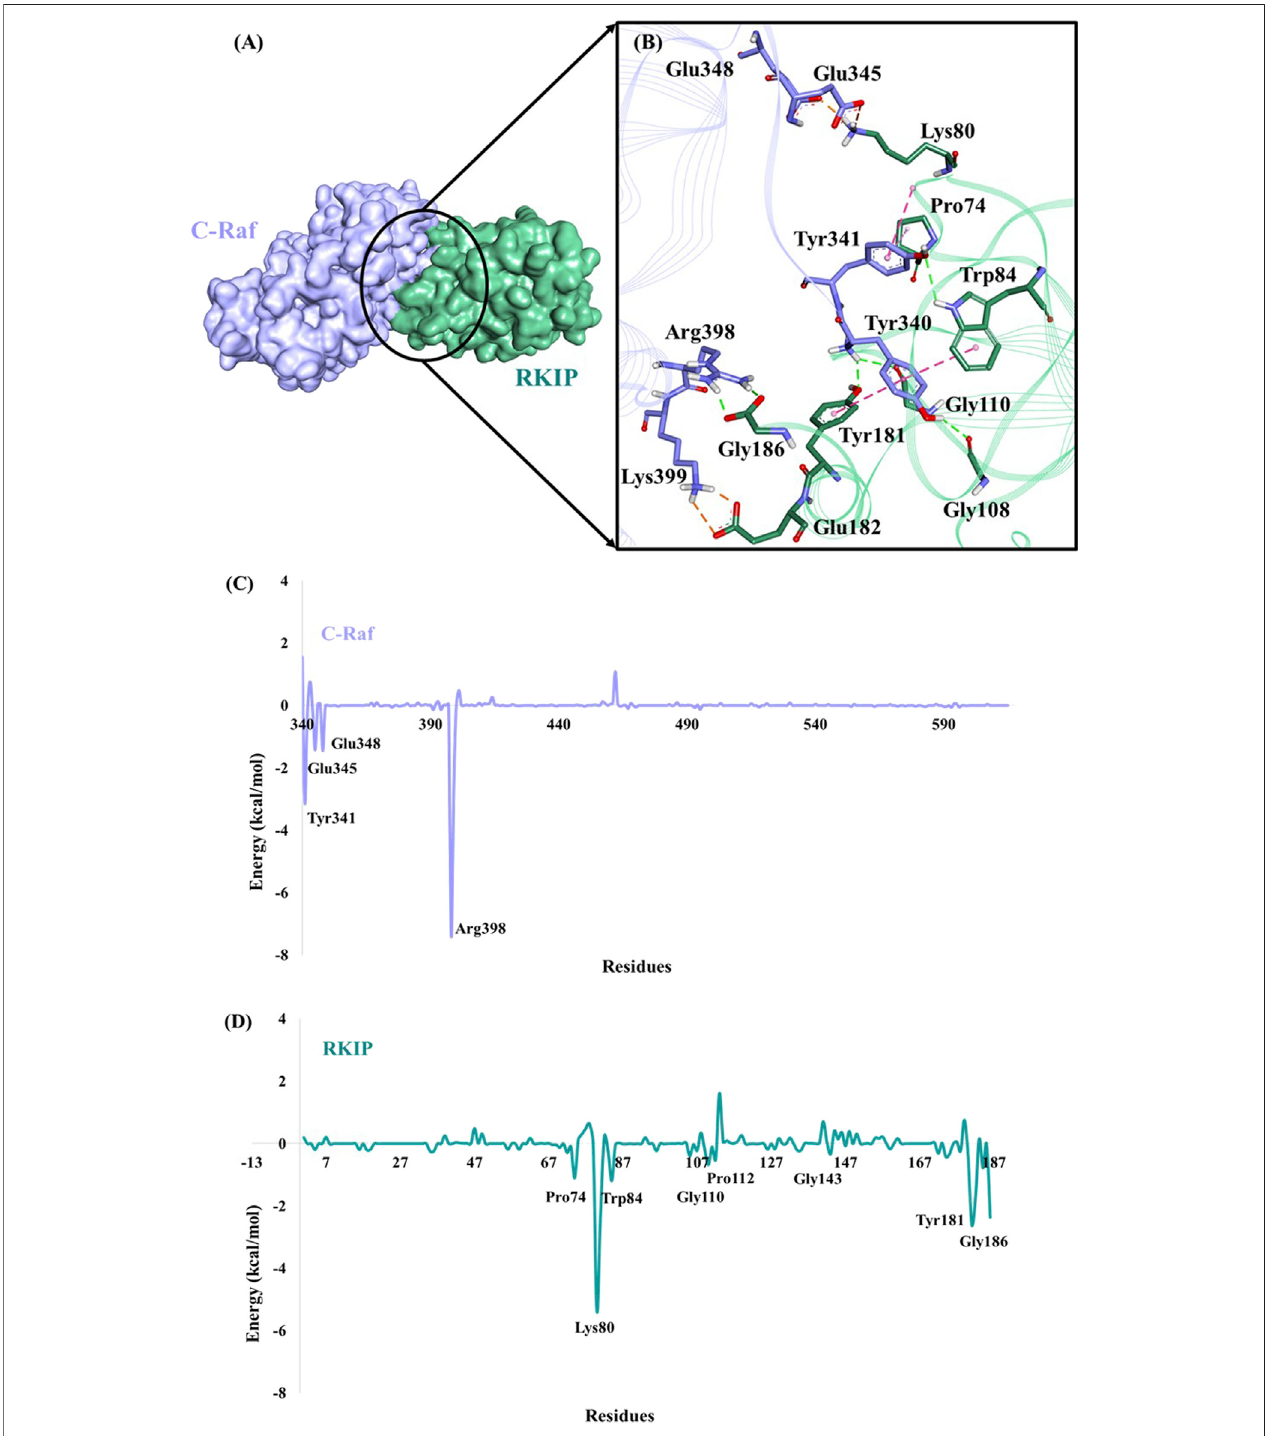
FIGURE 4 | Binding mode of C-Raf/RKIP structural complex and MM/GBSA analysis. (A) C-Raf (purple) and RKIP (mint green) shown in surface representation. (B) Close-up view of the intermolecular interactions between C-Raf and RKIP. Interacting residues are represented in stick form. Hydrogen, hydrophobic and electrostatic bondsare shown as green, pink and brown dashed lines, respectively. Per-residue energy contribution (kcal/mol) of key residues in (C) C-Raf and (D) RKIP.